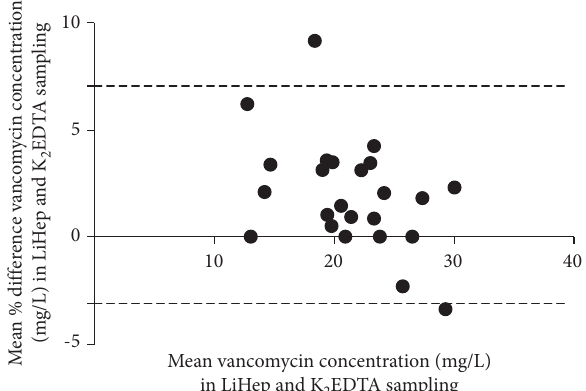
Figure 2: Bland–Altman plot of the diferences in vancomycin concentrations from LiHep and K 2 EDTA samples. Te black- dashed lines represent the 95% confdence interval. LiHep, lith- ium heparin; K 2 EDTA, dipotassium ethylenediaminetetraacetic acid; mg/L, milligram per